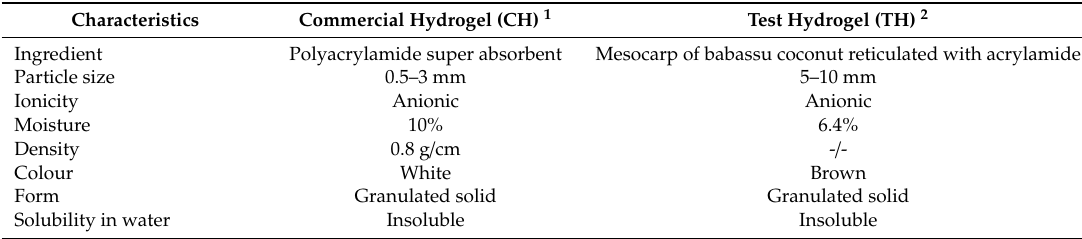
Table 1. Physicochemical characteristics of